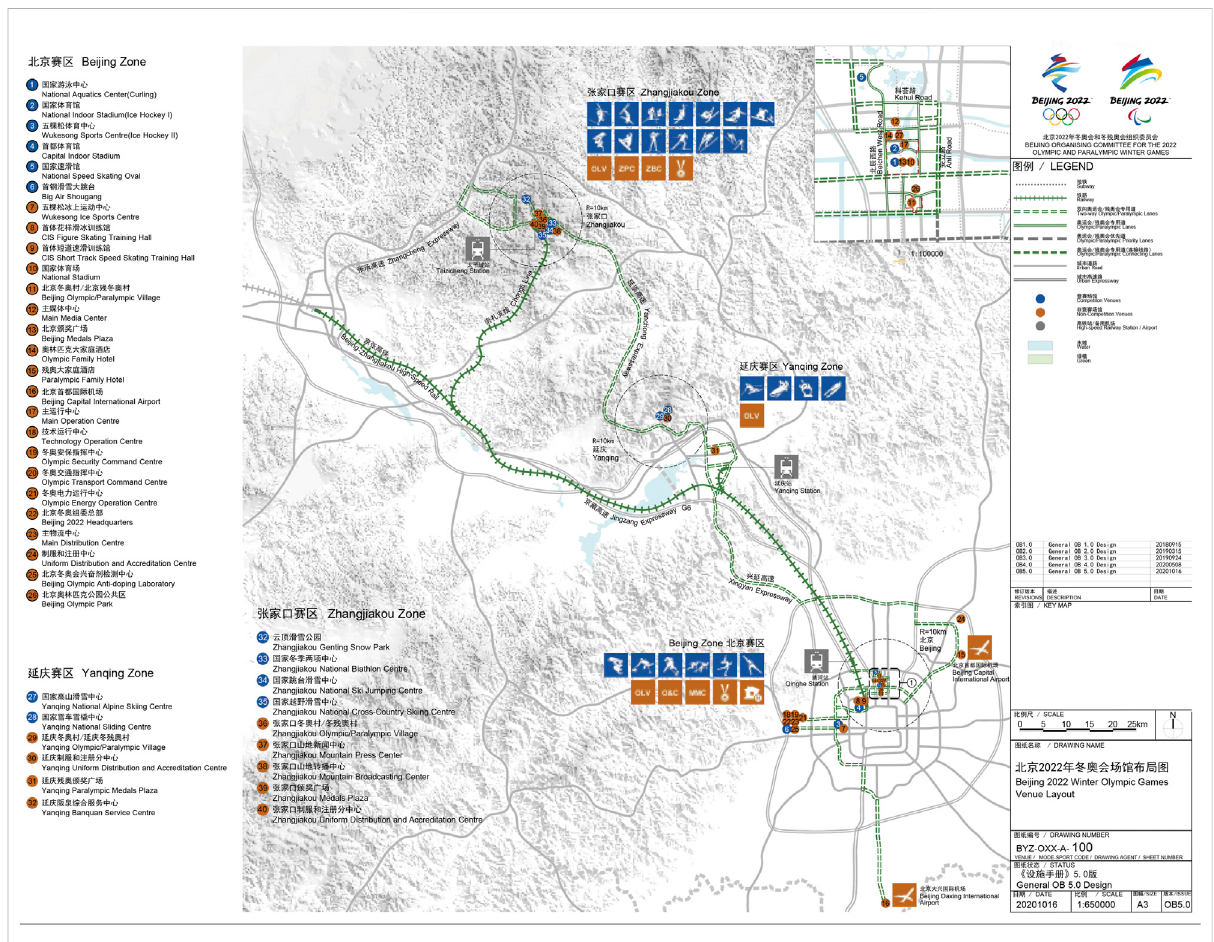
FIGURE 1 Beijing 2022 Winter Olympics venue layout. The photo was openly available from the Beijing Organising Committee for the 2022 Olympic and Paralympic Winter